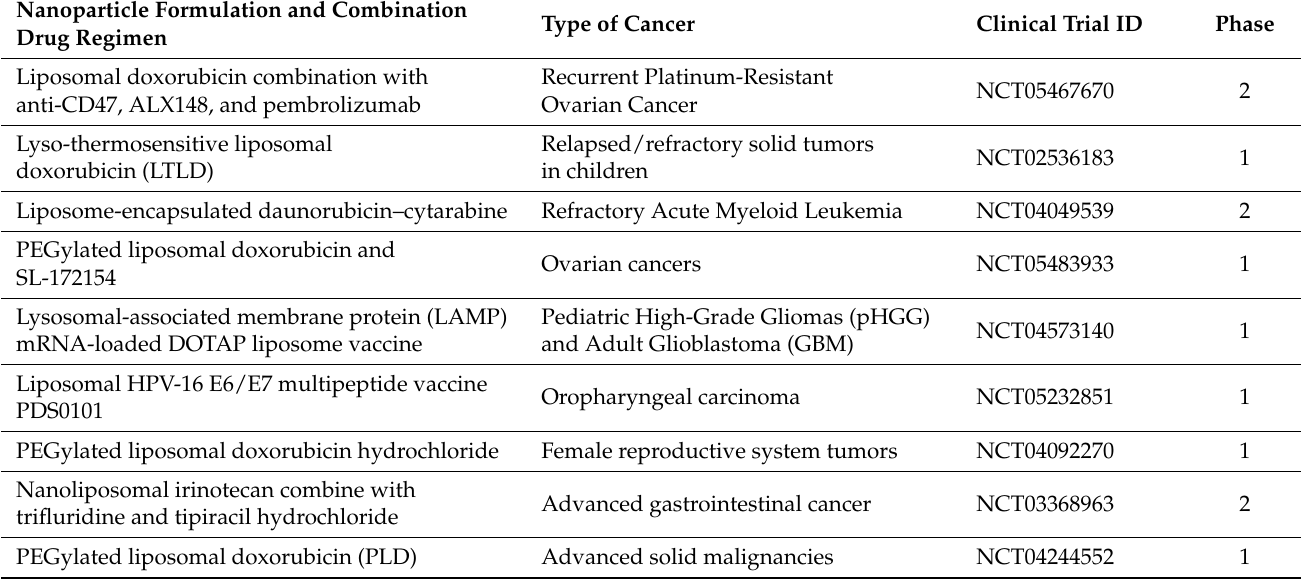
Table 1. Current lipid nanoparticles for cancer treatment and drug regimens being studied in clinical trials. Date from